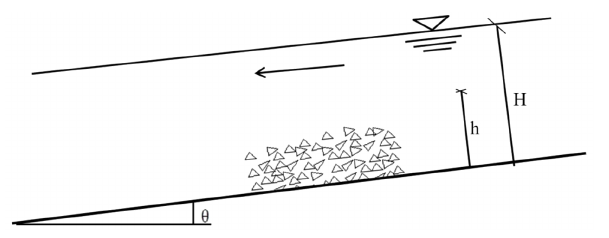
Figure 11. The typical debris flow initiate model.